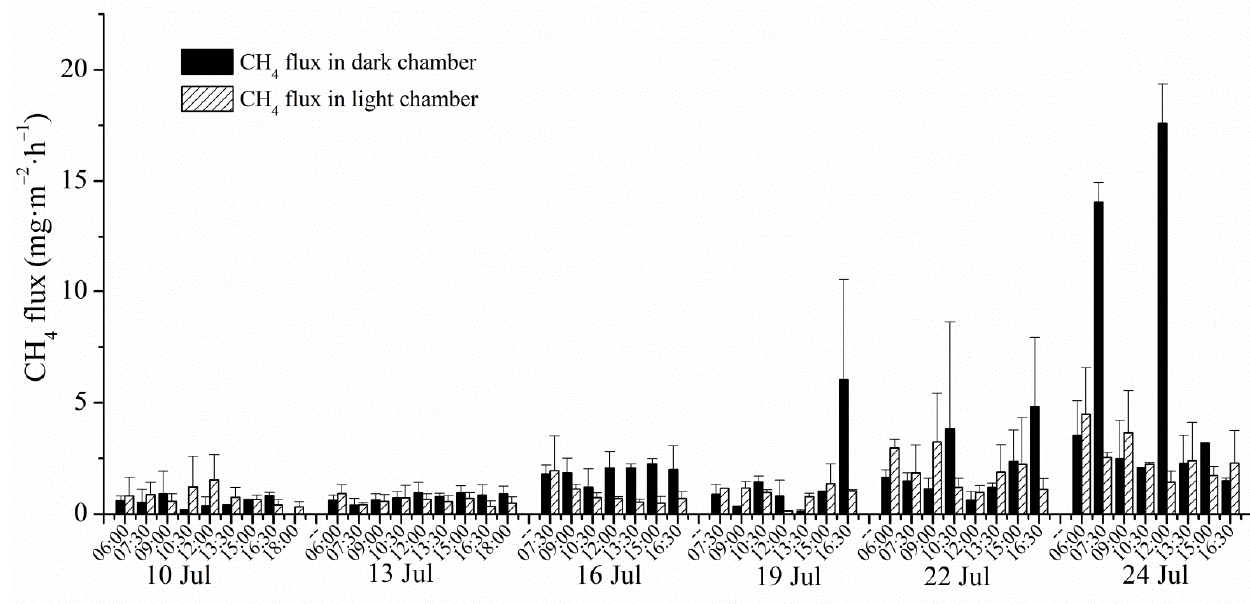
Figure 3. Variations of CH 4 fluxes in both dark and light chamber during the 15-day tidal cycles.